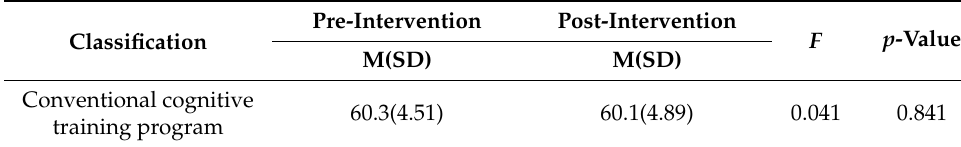
Table 7. Differences with pre- and post-intervention of control group.